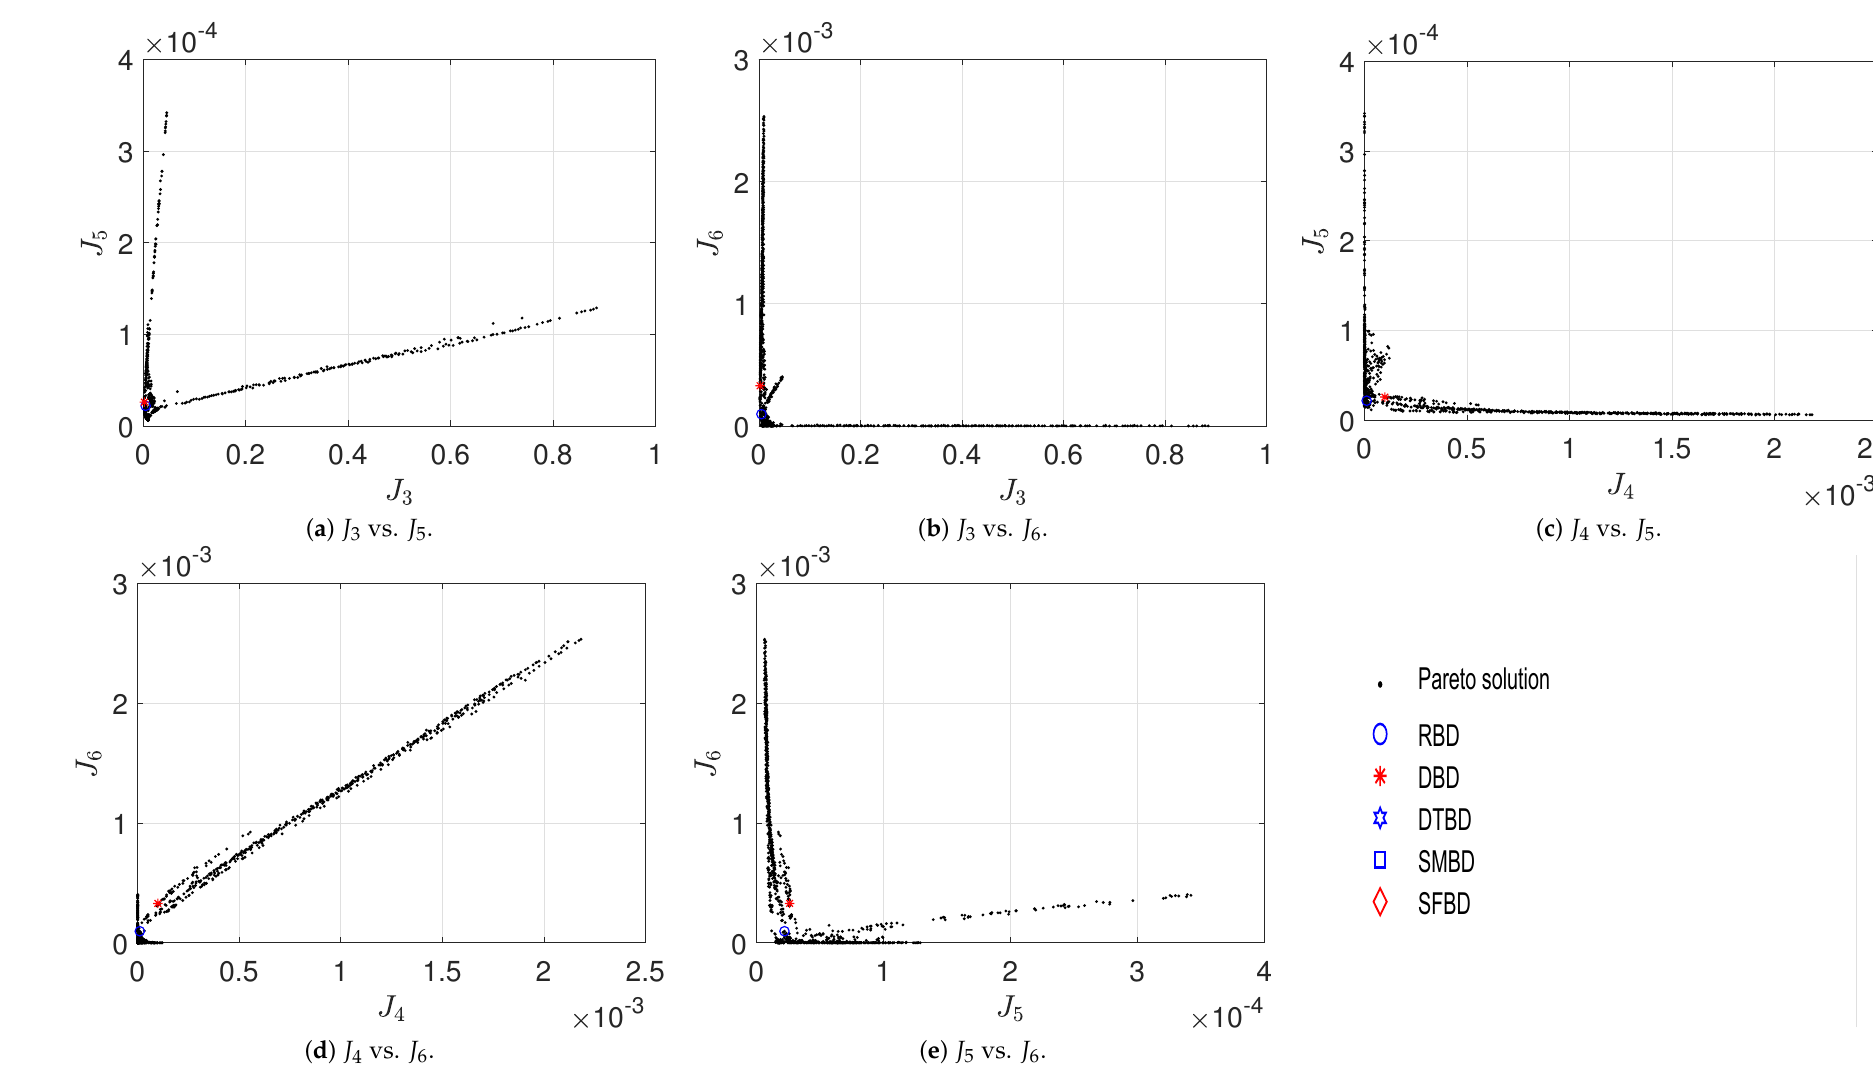
Figure 6. Pareto front in two-dimensional spaces